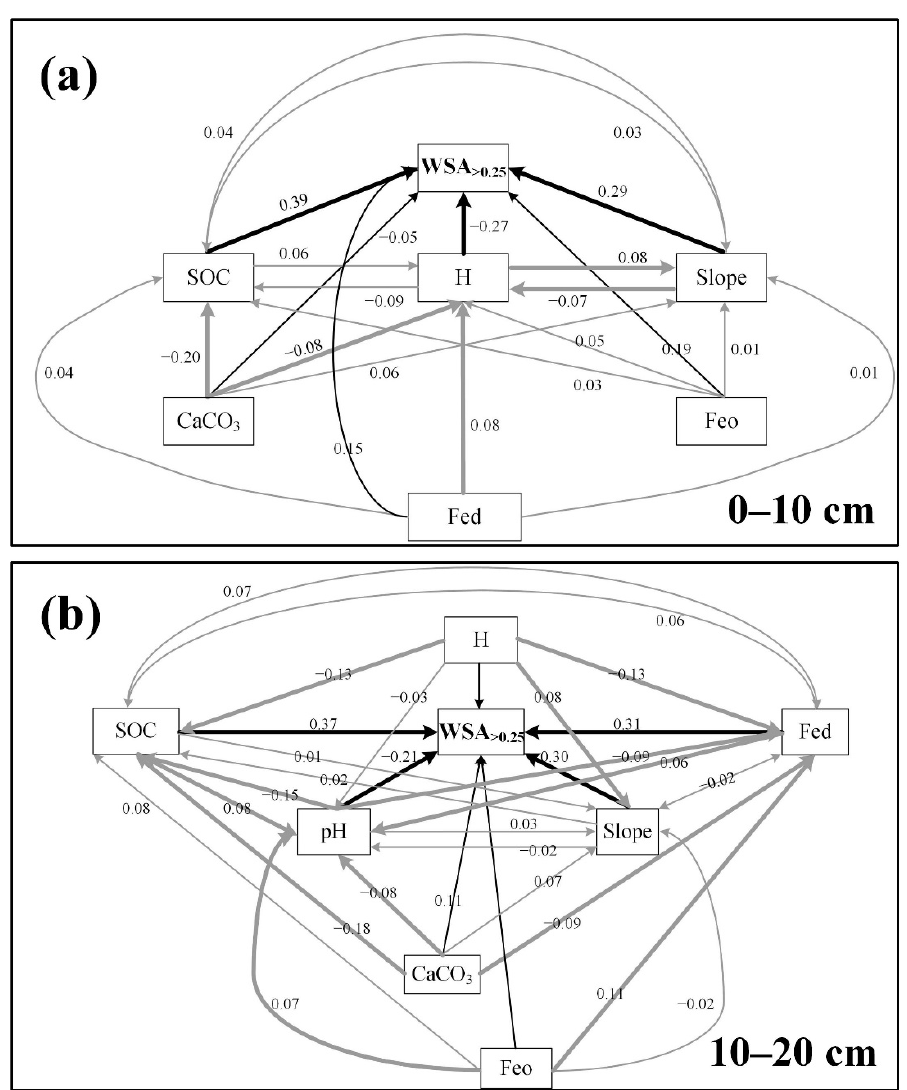
Figure 5. Path analysis results on the direct and indirect effects of soil, nature, and land use on WSA >0.25 at 0–10 cm ( a ) and 10–20 cm ( b ) in the Zhifanggou watershed. Numbers show the path coefficients. Black and grey paths indicate direct and indirect effects, respectively. Thick lines indicate significant relationships ( p < 0.05), and the fine lines indicate non-significant relationships. SOC, soil organic carbon; CaCO 3 : calcium carbonate; Fe d : free iron; Fe o , amorphous iron; H: elevation; WSA >0.25 : percentage of water-stable aggregates greater than 0.25 mm.